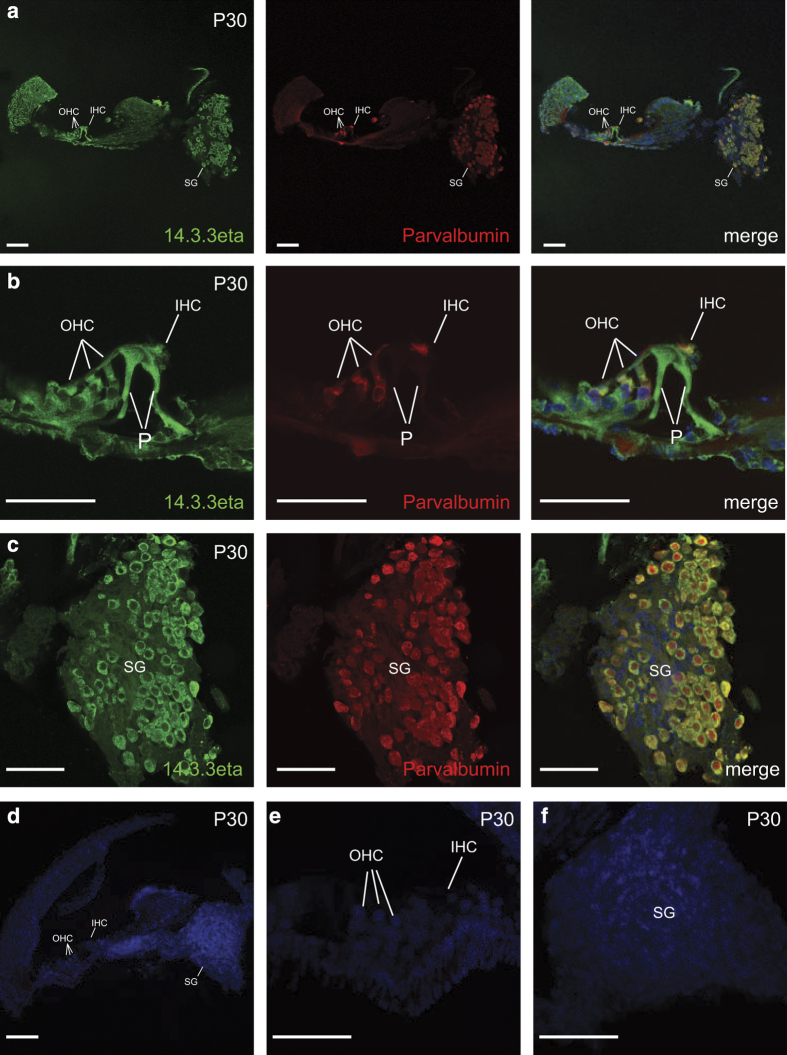
14-3-3eta expression in cochlea. Microdissected adult (P30) mice cochlea were stained with Hoechst and immuno-labeled with an anti-14-3-3eta antibody (in green) and antiparvalbumin antibody (in red) to identify hair cells and spiral ganglion neurons. (a) Strong expression of 14-3-3eta was localized in inner (IHC) and OHCs, pillar cells (P) and spiral ganglion (SG). (b) Higher magnification image of organ of Corti showing staining of hair cells and pillar cells. (c) Higher magnification image of spiral ganglion neurons. (d) Control section of cochlea. (e) Control section of the organ of Corti. (f) Control section of spiral ganglion neurons showing no staining. Scale bar represents 100 μm.